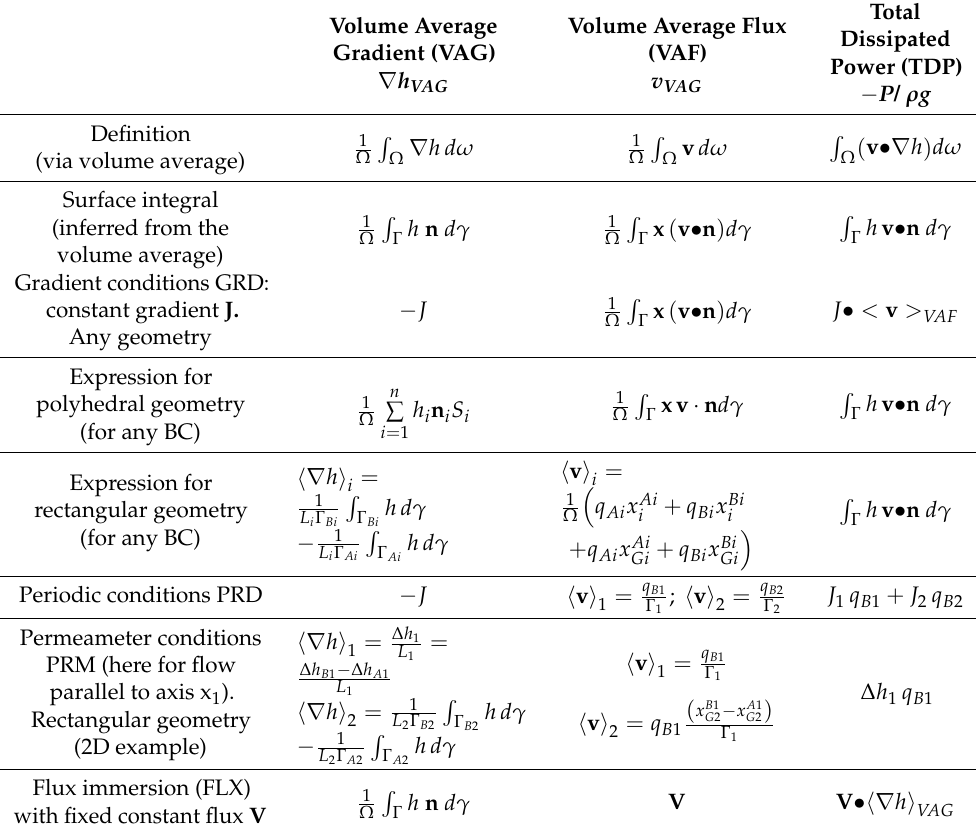
Table 2. Equivalent permeability criteria: specialization of volume averages to surface averages for specific boundary conditions and block geometries (see Appendix A.7 for